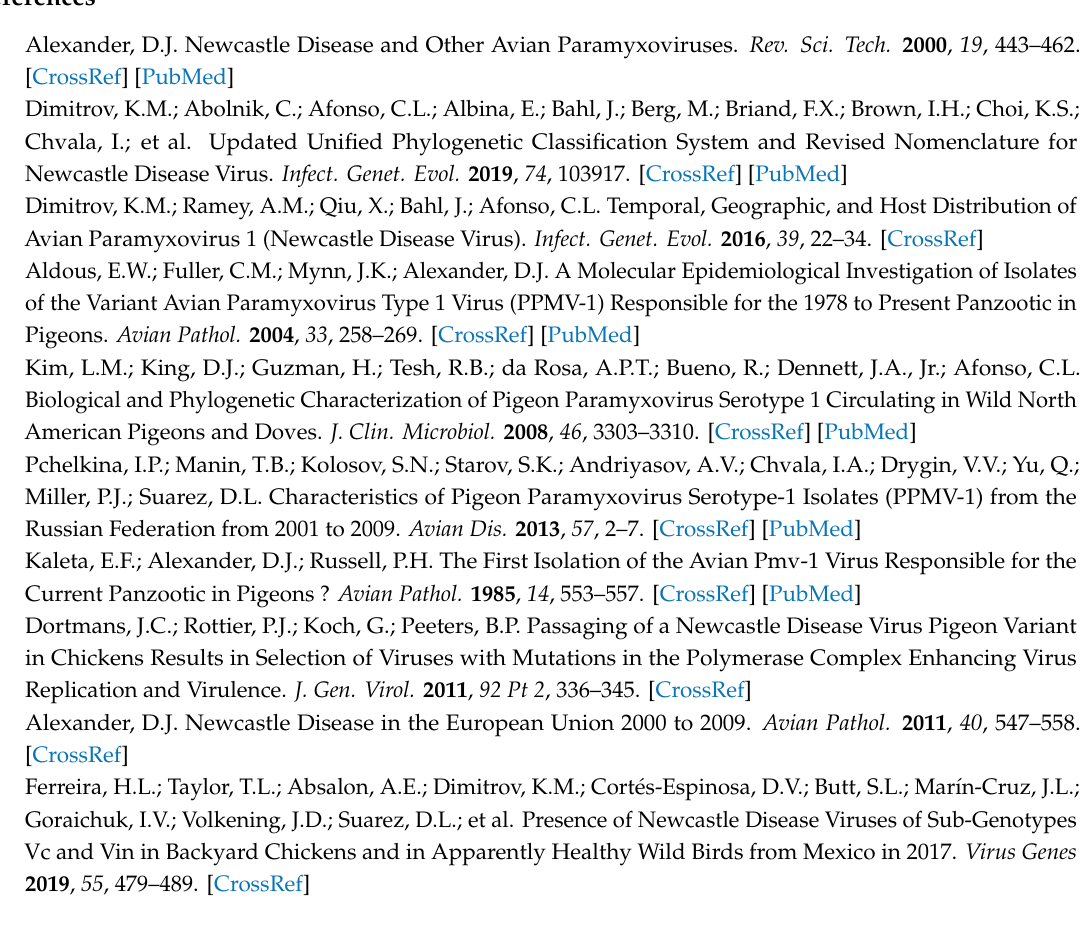
Figure S1: Results of the location-randomization analysis, Table S1: The TMRCA of di ff erent sub-genotypes in genotype